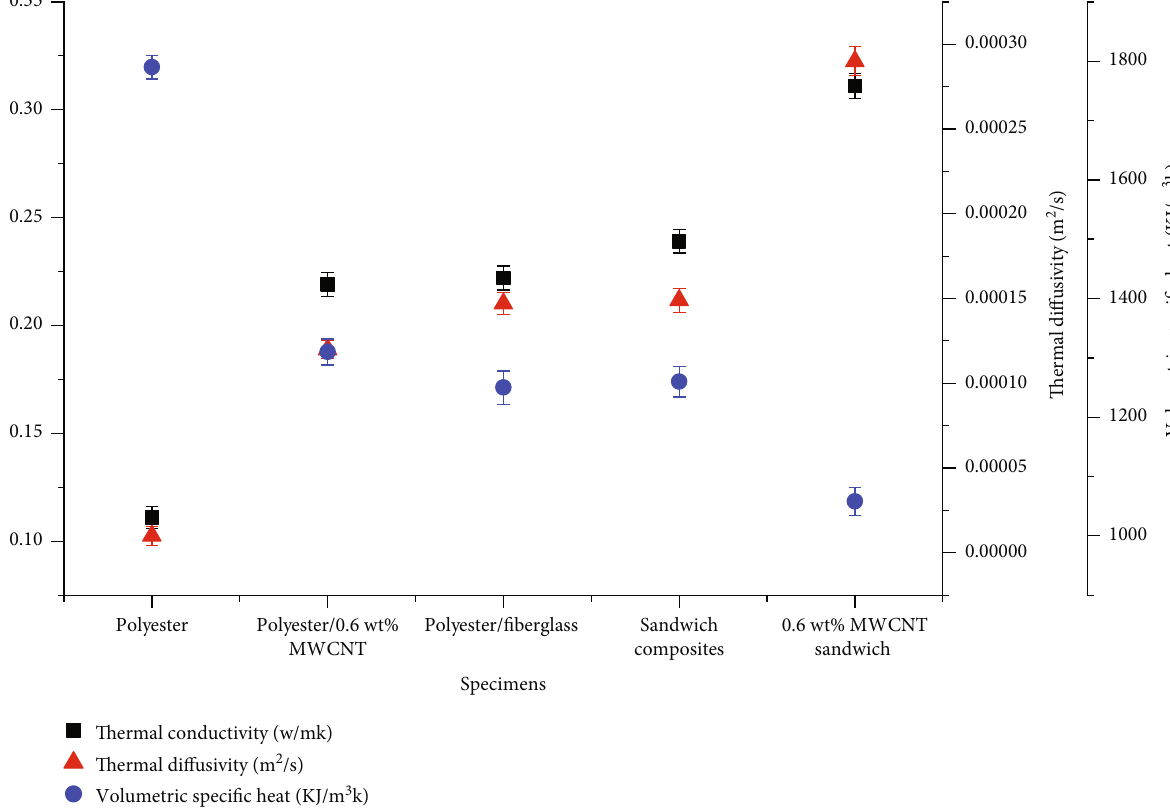
Figure 13: Thermal properties of polyester based various forms of composites.